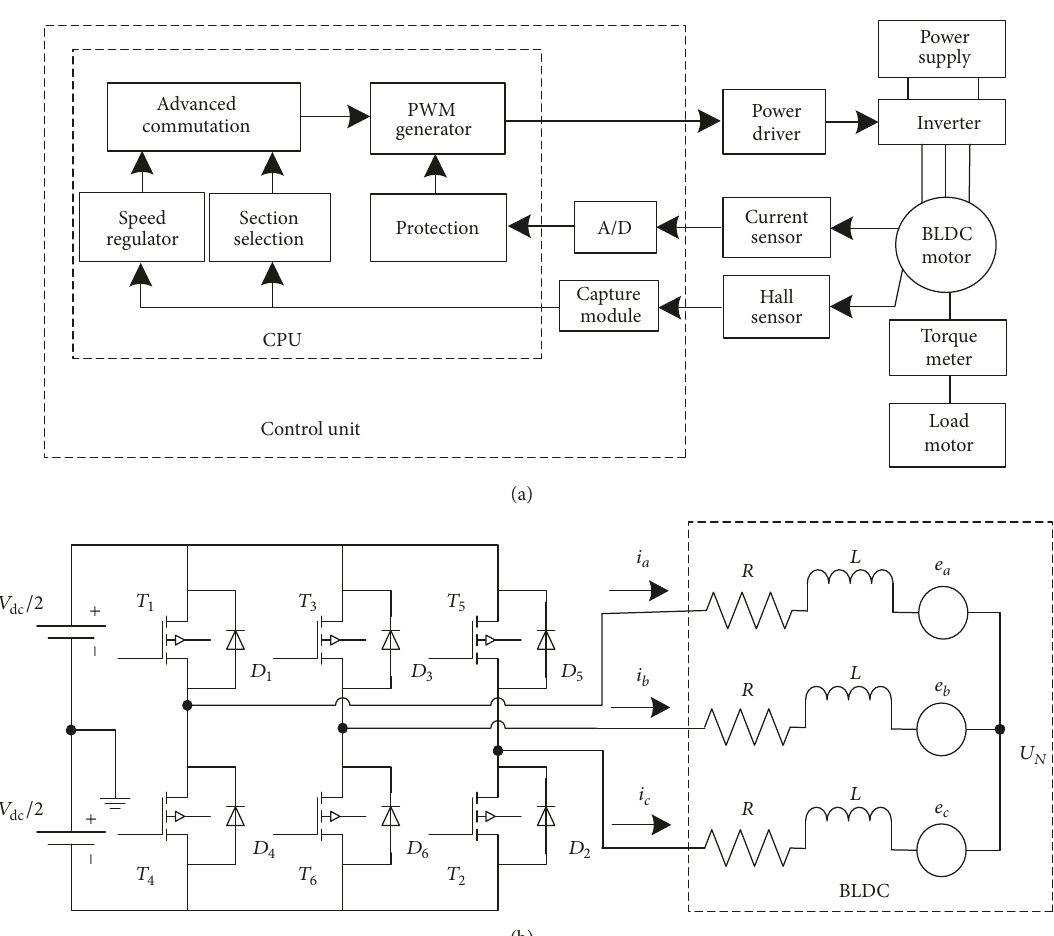
Figure 1: (a) The block diagram of advanced commutation control. (b) The driving circuit and equivalent circuit of the